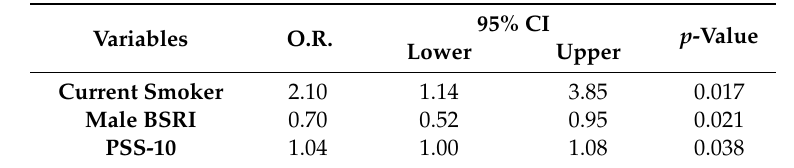
Table 5. Factors associated with low adherence to the Mediterranean diet, evaluated by logistic regression analysis, regardless of age, sex, and